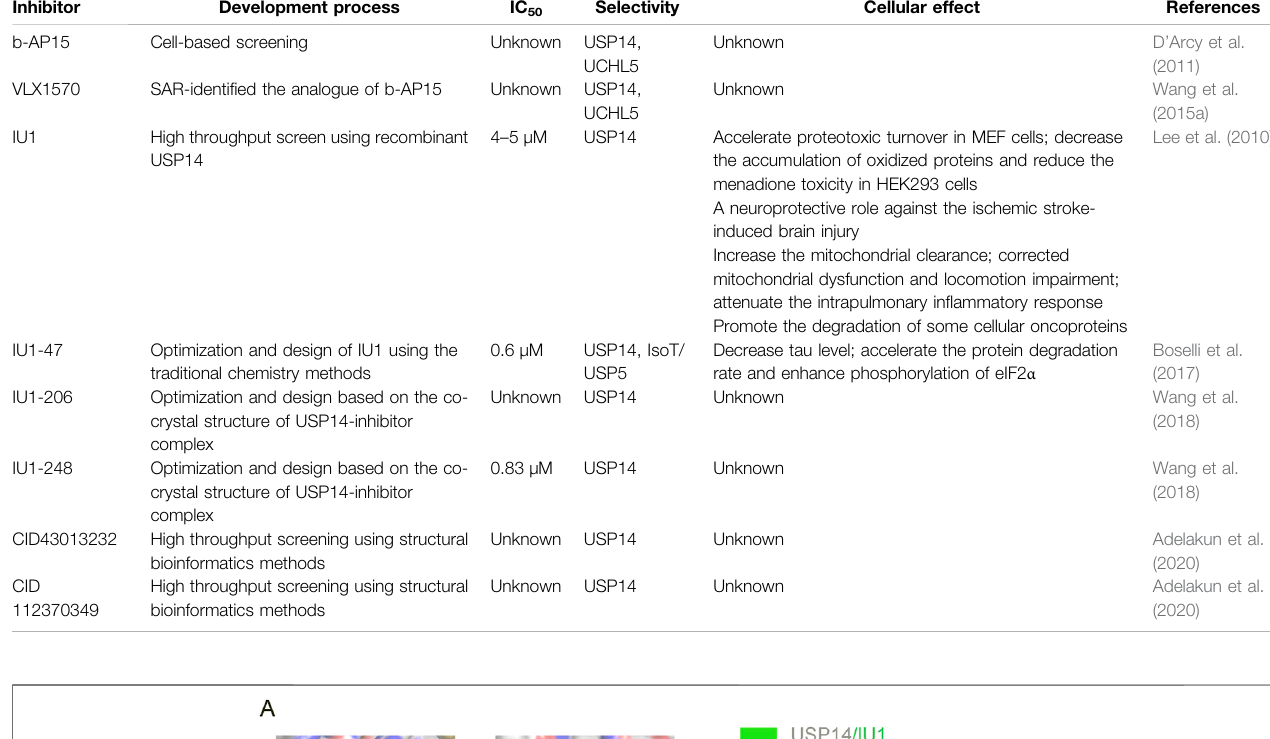
TABLE 1 | The development process and characterization of USP14 inhibitors.